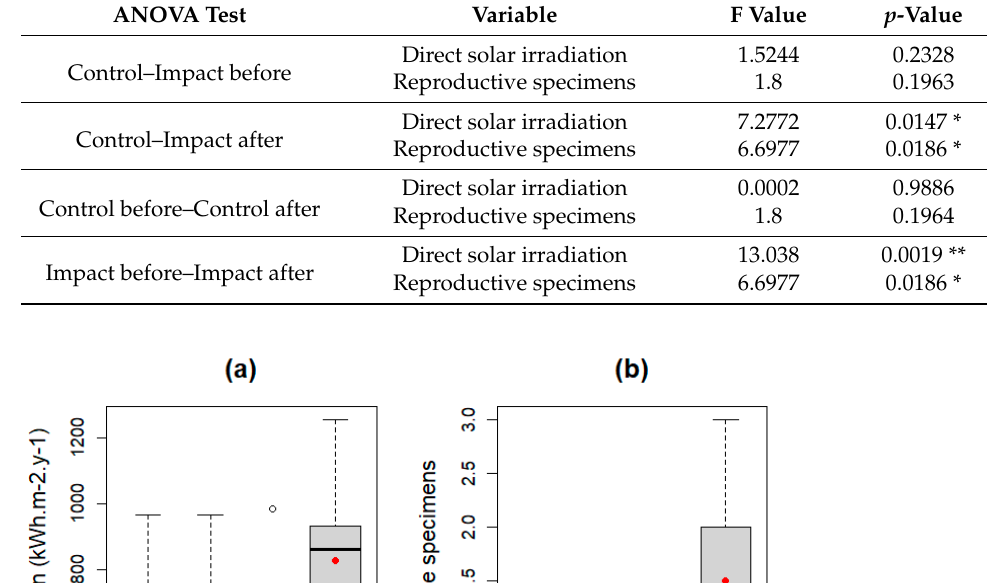
Table 3. Observed changes in the main reproductive parameters. * Among these specimens, 11 were from 2017 and 30 from